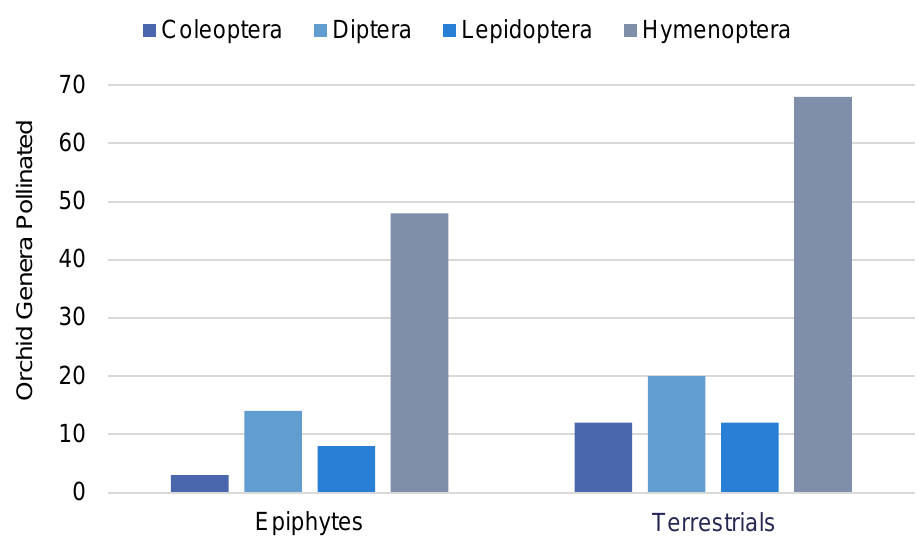
Figure 2. The total number of orchid genera (epiphytic and terrestrial) that are pollinated by each of the four major orchid pollinating insect orders. The Coleoptera and Hymenoptera display significantly different results between epiphytic and terrestrial orchid genera ( P = 0.00046 and P =